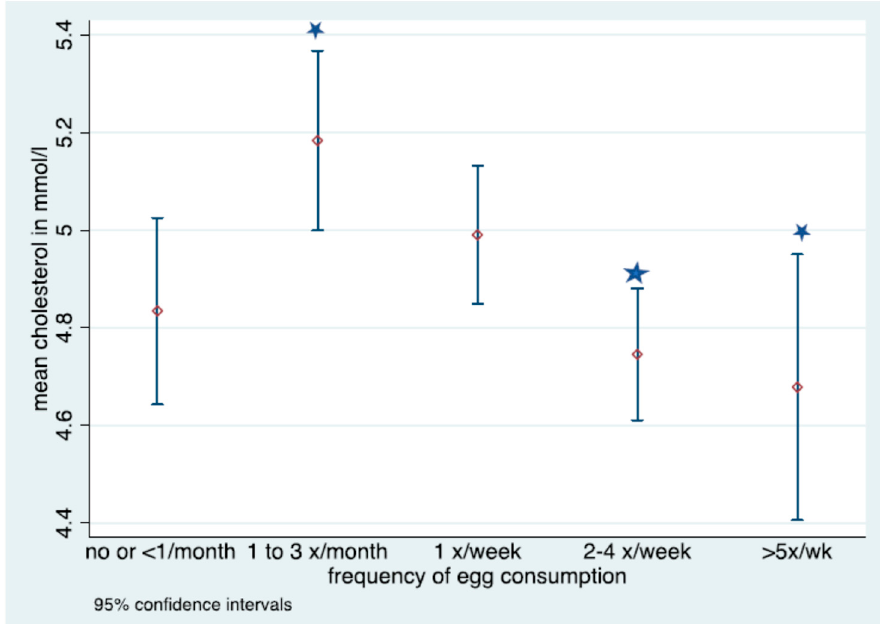
Figure 2. Mean cholesterol and 95% confidence intervals by egg consumption in the measured subpopulation Cholesterol measured in mmol/L. Denotes significant difference in frequency of